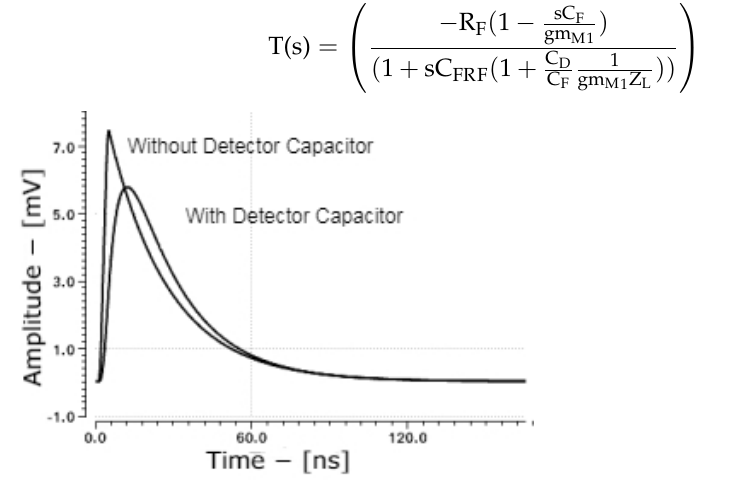
Figure 3. Transient response of CSP with and without a detector